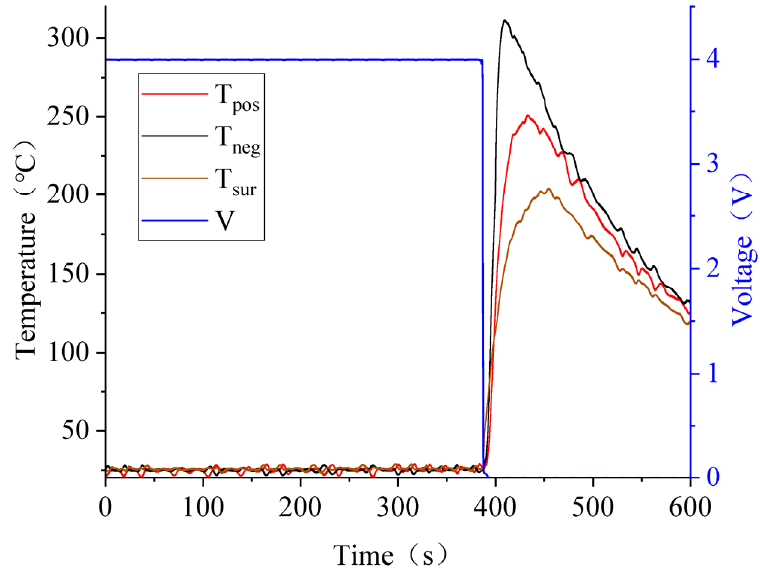
Figure 16. Eighty percent SOC state battery curve.